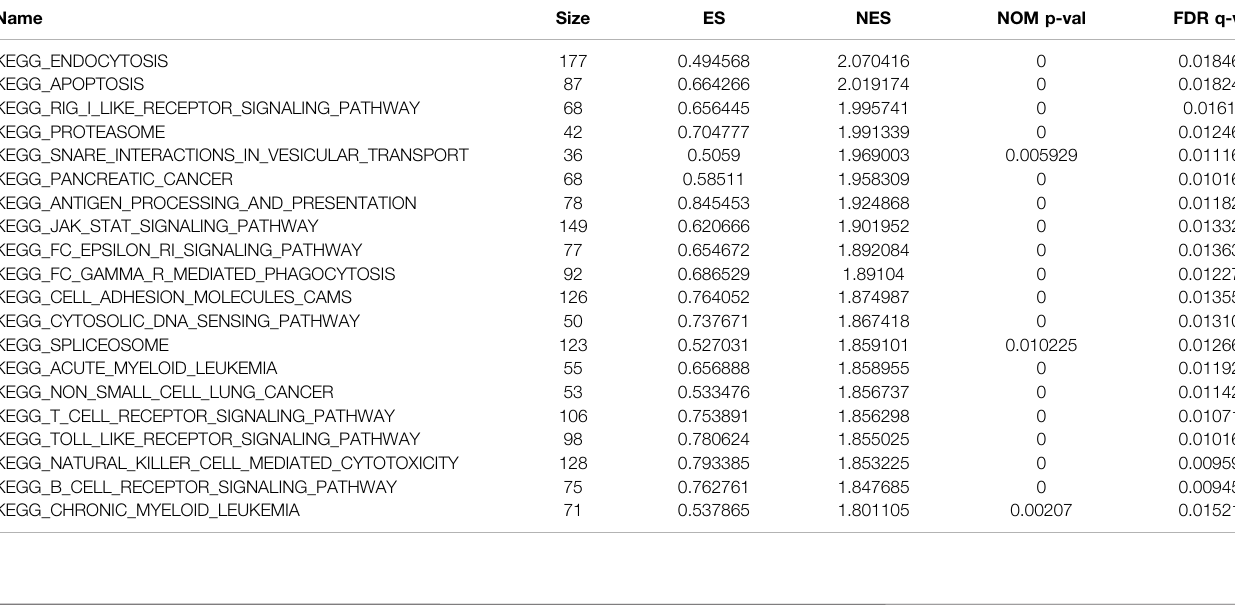
TABLE 2 | Top 20 results of GSEA enrichment analysis.